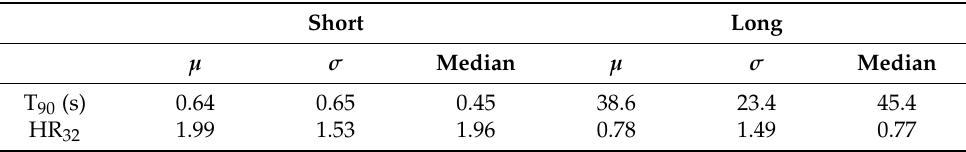
Table 4. Mean ( µ ), standard deviation ( σ ), and median of the properties of the Fermi /GBM ‘long’ and ‘short’ classes identified by clustCombi